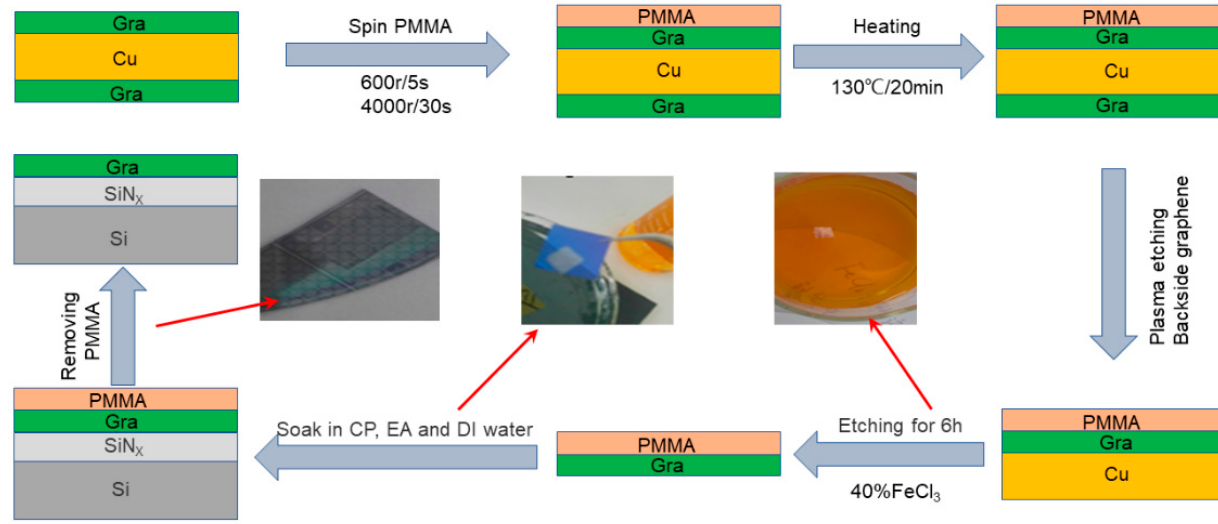
Figure 1. Schematic diagram of graphene transferring process.